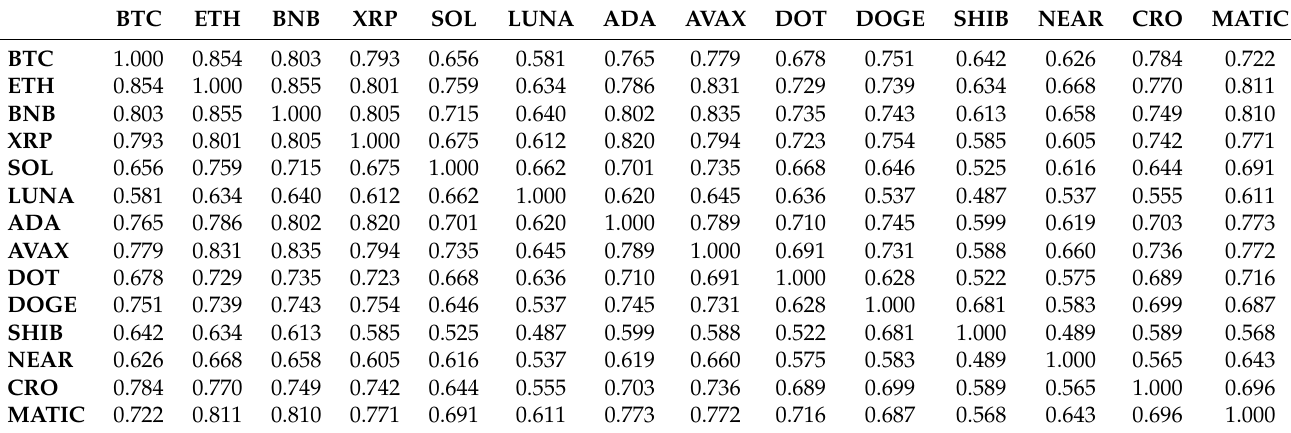
Table 9. Cross-correlations of the 14 portfolio